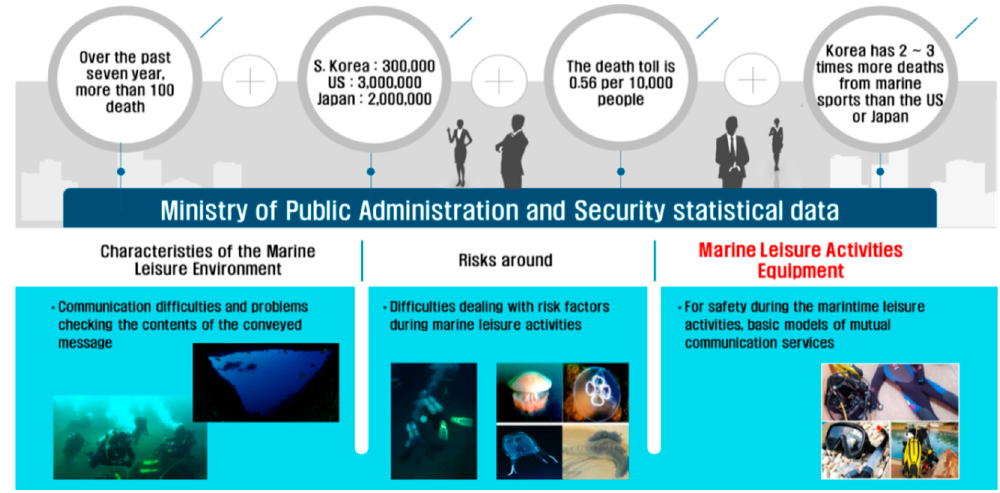
Figure 1. Statistical data in terms of marine safety accidents.